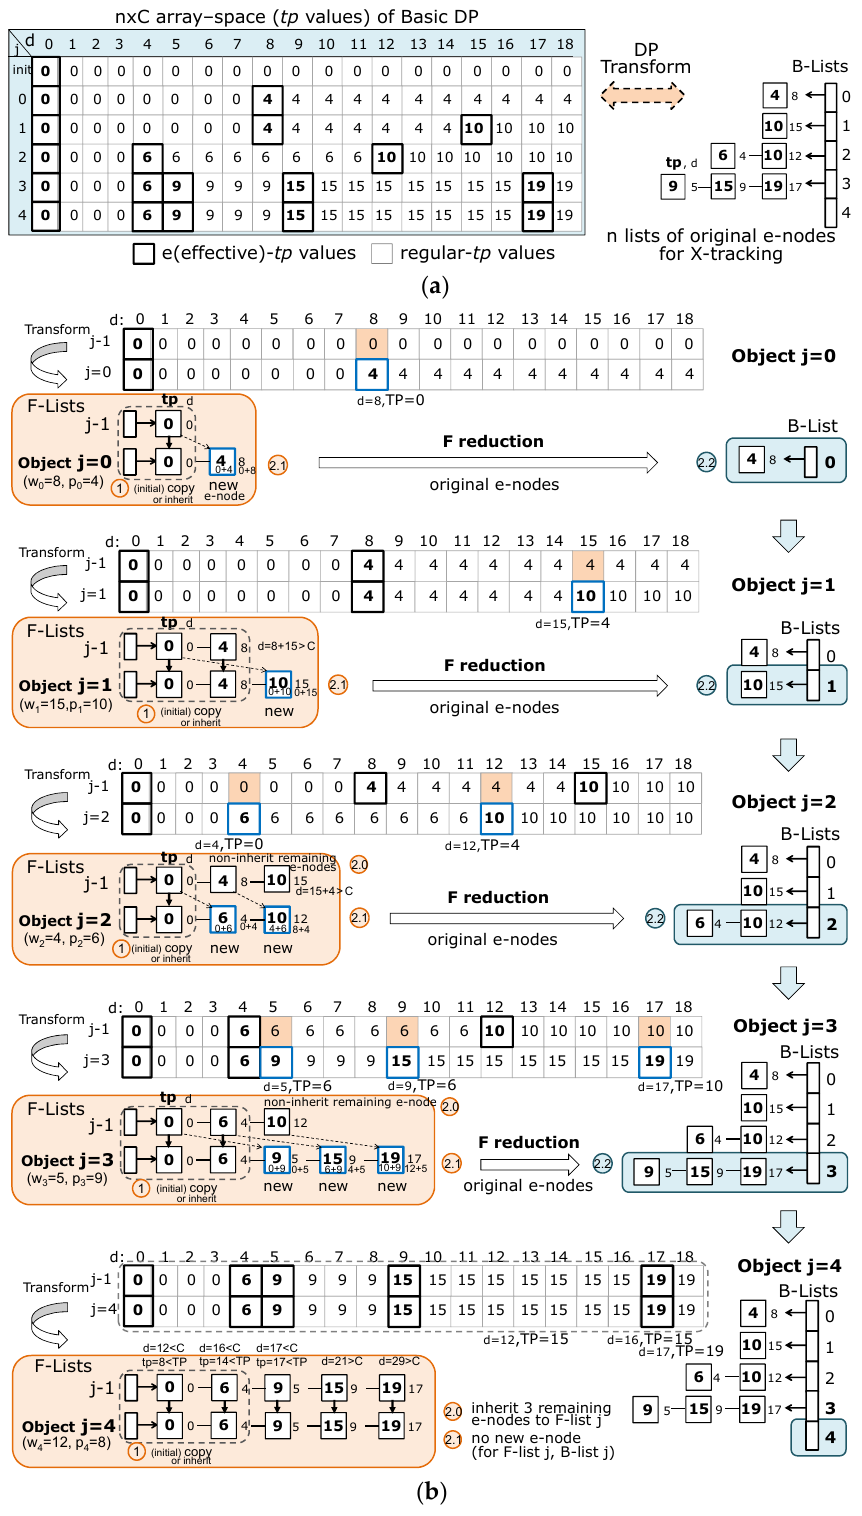
Figure 5. An example of preprocessing ( n = 5, C = 18): ( a ) n x C array ( tp ) by the basic DP and ( b ) two F-lists and n B-lists by DPT-List TSR for objects j = 0–4.